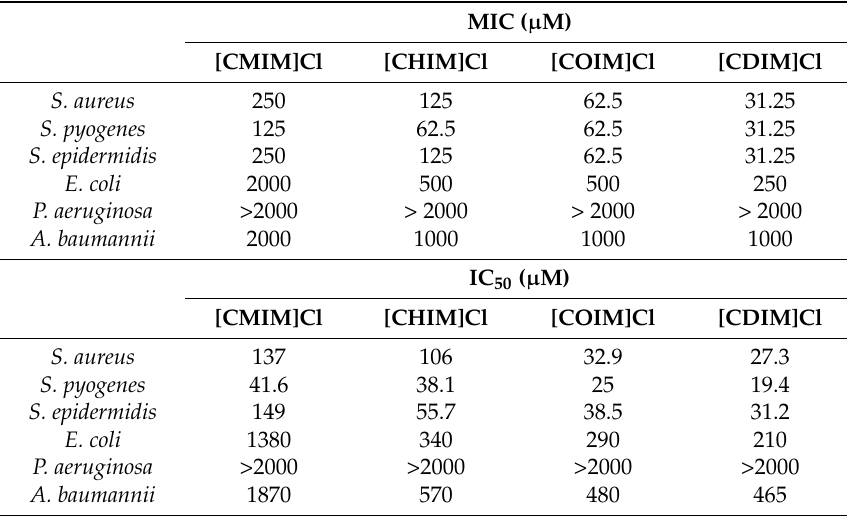
Table 3. Minimum inhibitory concentration (MIC) and calculation of mean viability inhibition (IC 50 ) of Gram-positive and Gram-negative